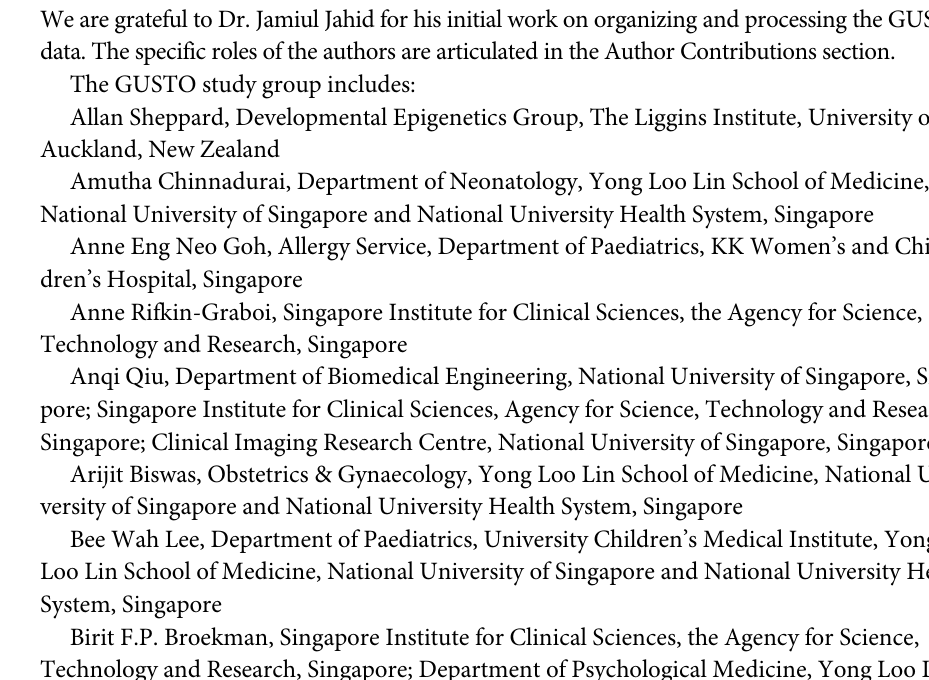
phenotypes for both pair-wise and three-variable dependency. SNPs that occur in more than one category (gender or phenotype) are identified with the same color. The "exm" SNPs that were excluded from the downstream analysis are highlighted in red. S5 Table. Preprocessing of SNPs in X and Y chromosomes. (XLSX) S6 Table. The RegulomeDB score for 148 candidates associated with either neurological, growth parameters or both using Mutual Information and Delta3 dependency measures respectively. Variants that returned "no data" are not included. S7 Table. Tissue specific gene expression evidences using GTEx and regulatory function scores from RegulomeDB for the candidate SNPs. S8 Table. Selected SNPs in the top 3 scoring categories of RegulomeDB, with the most likely regulatory functions. (XLSX) S1 Fig. The one-SNP three-gene structure. The SNP rs178850 has the best p-value (2x10 -8 ) of those identified in a three-way dependency with Adaptive (Bayley phenotype) and lambda (growth phenotype). This SNP is located in the intronic region of RAB11FIP4 gene on chro- mosome 17 and is also very close to NF1 and OMG, which is located within NF1. All three of these genes affected by rs178850 are highly expressed in